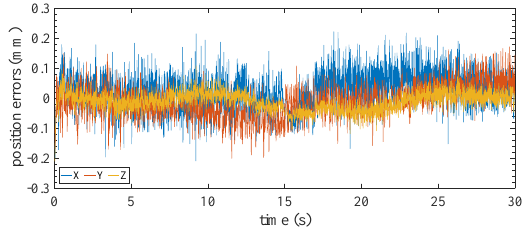
kinematics, planning the trajectory of motion, simulating and controlling Robot in